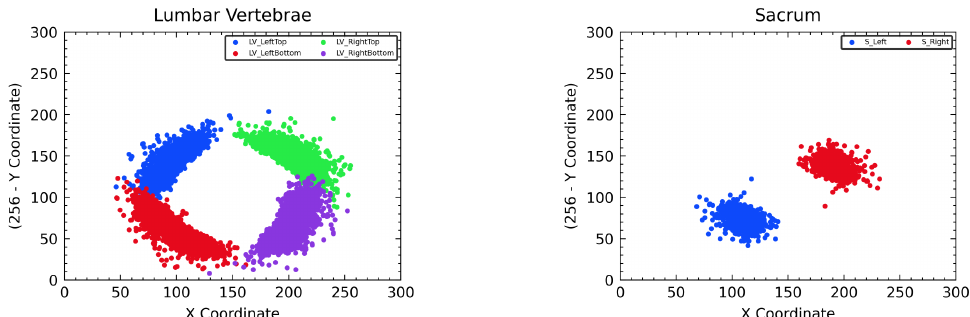
Figure 9. Distribution of all landmark coordinates in the cropped vertebra images for training M- Net. The left side represents the case of lumbar vertebrae, and the right side represents the case of the